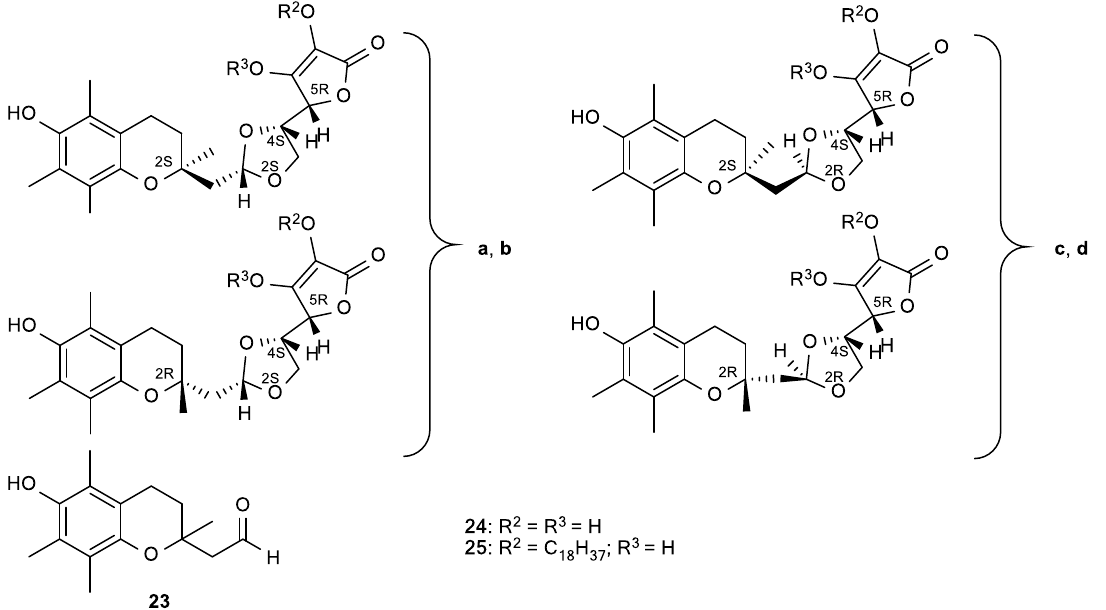
Figure 9. The antioxidant agents derived from a molecular combination of the L -ascorbic acid and α -tocopherol. Table 5. The antioxidant activity of vitamin C and E conjugates determined by the lipid peroxidation assay.